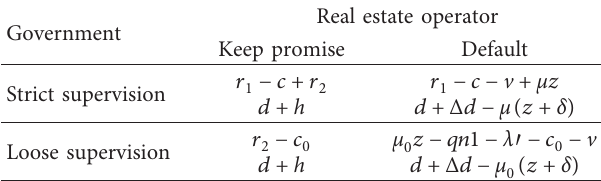
Table 1: Payment matrix of government and real estate operators. Government